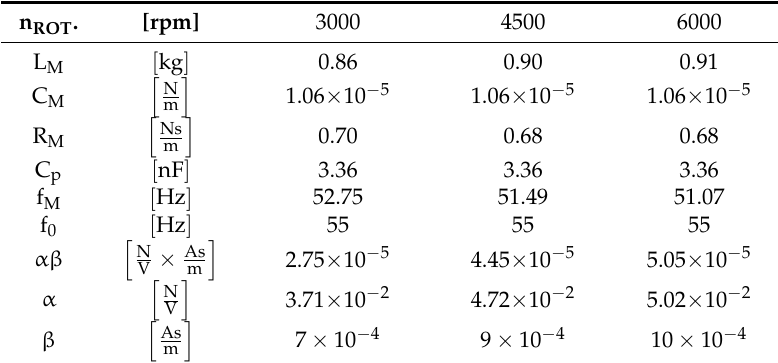
Table 12. Equivalent electric circuit parameters.